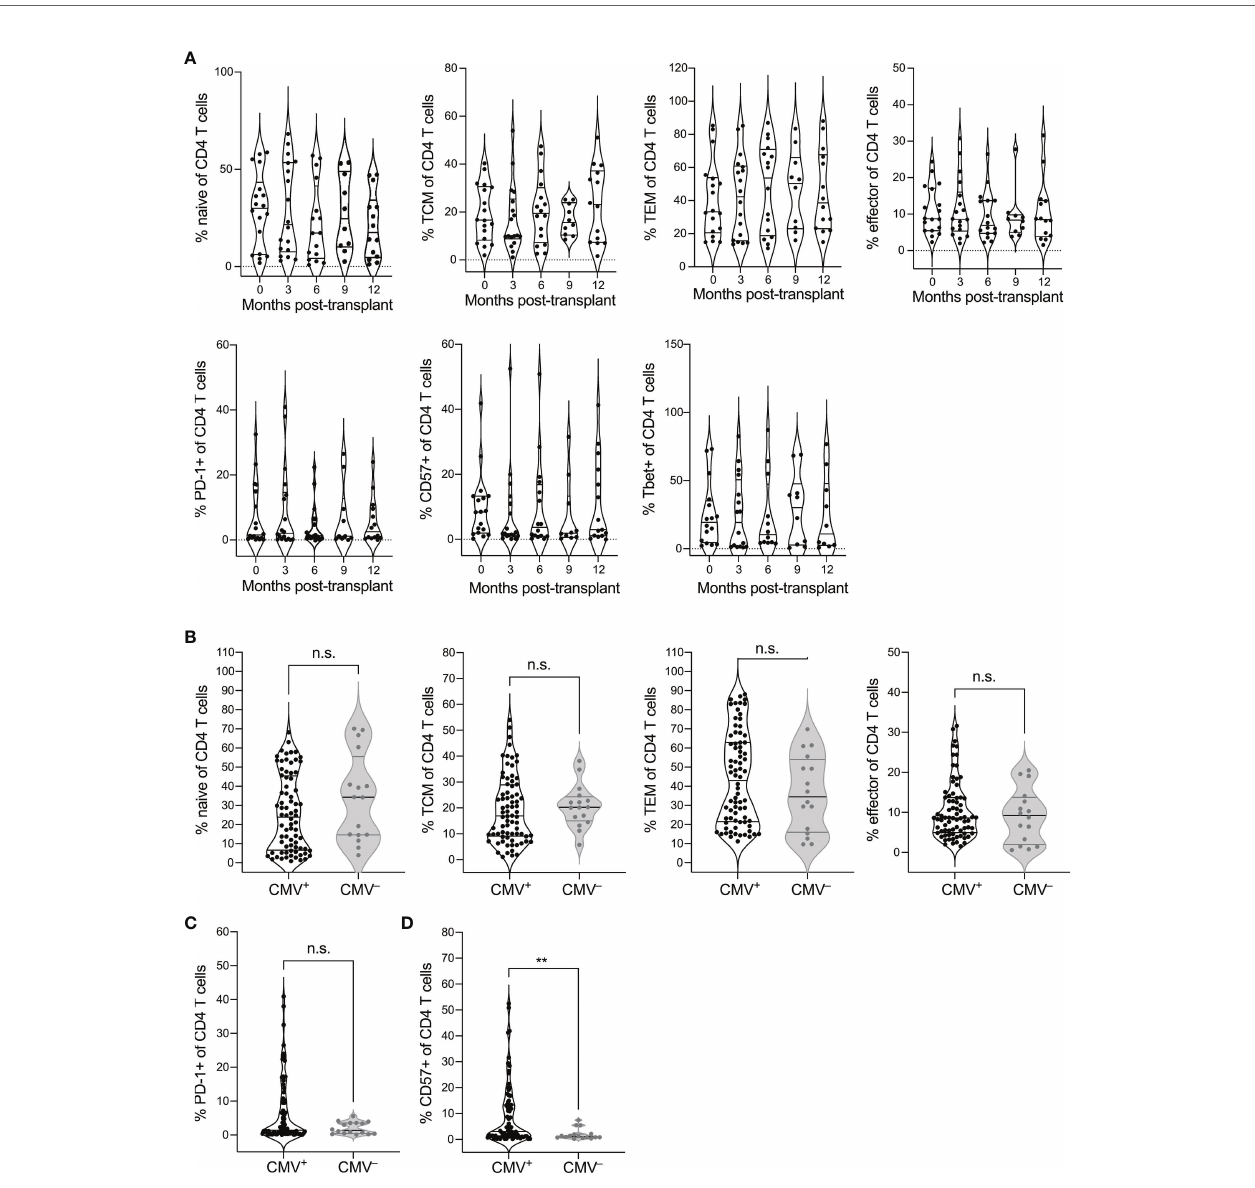
FIGURE 1 | CMV seropositivity affects CD4 T cell differentiation. PBMC from CMV + and CMV – solid organ transplant recipients at time points pre- and 3, 6, 9, and 12 months post-transplant were evaluated by fl ow cytometry for differentiation states of CD4 T cells, gated as live CD3 + CD8 – CD4 + CD14 – CD16 – CD19 – . CD4 T cells were gated as naïve (CCR7 + CD45RO – ), central memory (TCM, CCR7 + CD45RO + ), effector memory (TEM, CCR7 – CD45RO + ), and effector (CCR7 – CD45RO – ), or PD-1 + , CD57 + , or T-bet + . (A) Frequencies of (top) naïve, TCM, TEM, and effector CD4 T cells and (bottom) PD-1 + , CD57 + , and T-bet + cells at individual time points from pre- to a year post-transplant at three month intervals. Population frequencies were compared between CMV + and CMV – subjects for (B) naïve vs memory state, (C) PD-1 + cells, and (D) CD57 + cells across all time points. Violin plots depict density, and individual points represent individual samples. Statistics computed with (A) mixed-effects model with Tukey correction for multiple comparisons or (B – D) Mann-Whitney test. n.s. = not signi fi cant ** = p < 0.01. Data set previously published for analysis of CD8 T cells (25). n= 6 (CMV – ), 16-20 (CMV +